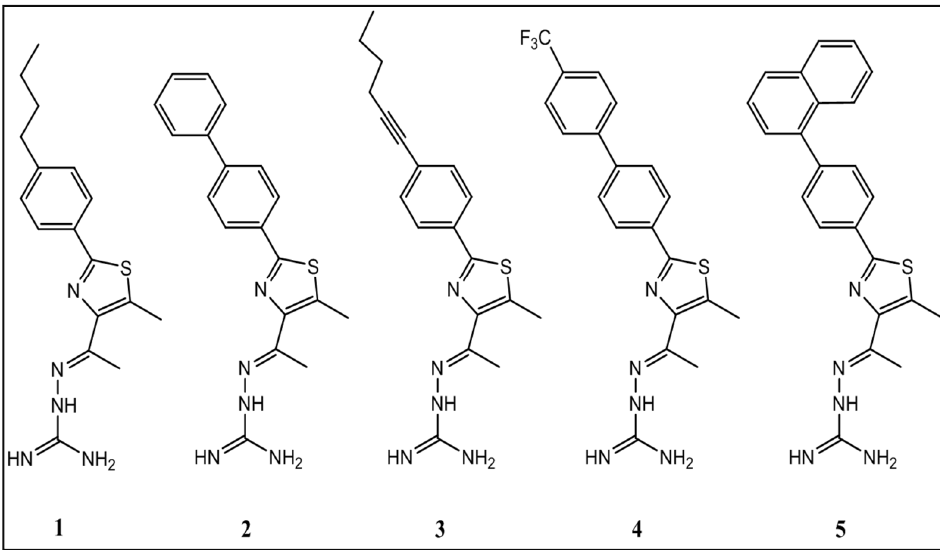
Figure 3. Chemical structures of thiazole compounds 1–5 (Adapted from Ref. [105]). The cells were cultured in Dulbecco’s modified Eagle medium (DMEM) supple- mented with 10% fetal bovine serum (FBS) at 37 °C with CO 2 (5%). Control cells obtained Dimethyl sulfoxide (DMSO) alone at a concentration equivalent to that in drug-treated cell samples. The cells were incubated with the compounds (in triplicate) in a 96-well plate at 37 °C with CO 2 (5%) for two hours before the addition of the assay reagent MTS 3-(4,5-dimethylthiazole-2-yl)-5-(3-carboxymethoxyphenyl)-2-(4-sulfophenyl)-2 H -tetrazol ium). Absorbance readings (at OD 490 ) were calculated using a kinetic microplate reader. After treatment with each compound, the extent number of viable cells was expressed as a percentage of the viability of DMSO-treated control cells. The toxicity data were ex- amined through a one-way Analysis of variance (ANOVA), with post hoc Dunnett’s multiple comparisons tests ( p < 0.05), utilizing GraphPad Prism 6.0. In vitro studies re- vealed that the thiazole compounds are nontoxic to human keratinocytes and negatively affect mammalian tissues. Furthermore, the antimicrobial activities of the thiazole com- pounds were confirmed by performing an in vivo analysis. The in vivo process evades the necessity to teach the antibody producer tis- sue-culture methods. When performing the in vivo method (i.e., mouse ascites method), a very high mAb concentration will be produced for this reason, there is no need for addi- tional concentration procedures, which can denature the antibody and reduce efficiency. In vivo strategies can create significant pain or trouble in mice. The mAb produced via in vivo methods can contain diverse contaminations that might need purification.